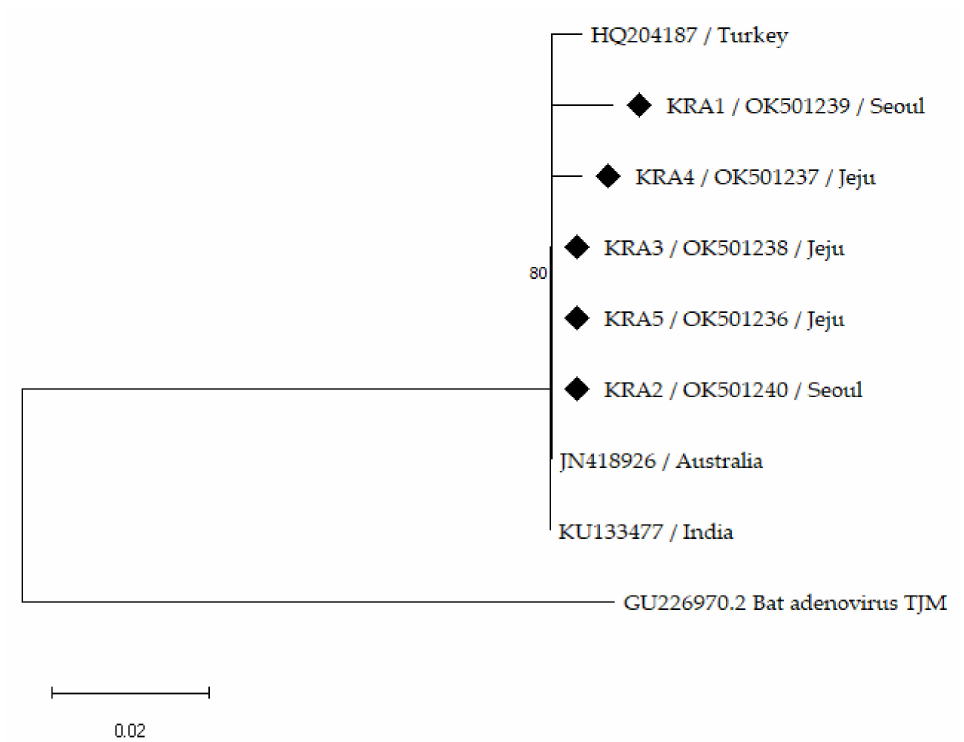
Figure 1. Phylogenetic tree constructed using neighbor-joining method based on partial hexon gene sequences of EAdV-1 with 1000 bootstrap replicates. Sequences of Korean horses are indicated by black diamonds with sample number, region of KRA facility, and GenBank accession number. GenBank accession numbers and country of foreign EAdV-1 strains are shown. Bat Adenovirus TJM (GU226970.2) was used for outgroup